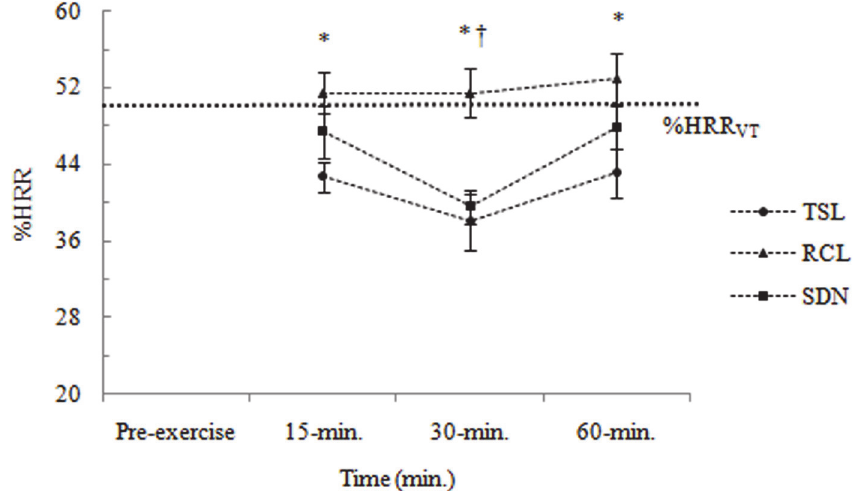
Fig 1. Physiological responses (i.e., %HRR) during the three Salsa dance conditions. Data are shown as means ± SE. TSL: Typical Salsa lesson; RCL: Rueda de Casino lesson; SDN: Salsa dance at a night club; %HRR: percent of heart rate reserve. %HRR VT : percent of heart rate reserve at-VT; VT: ventilatory threshold. * TSL significantly different from SDN; † TSL significantly different from RCL.